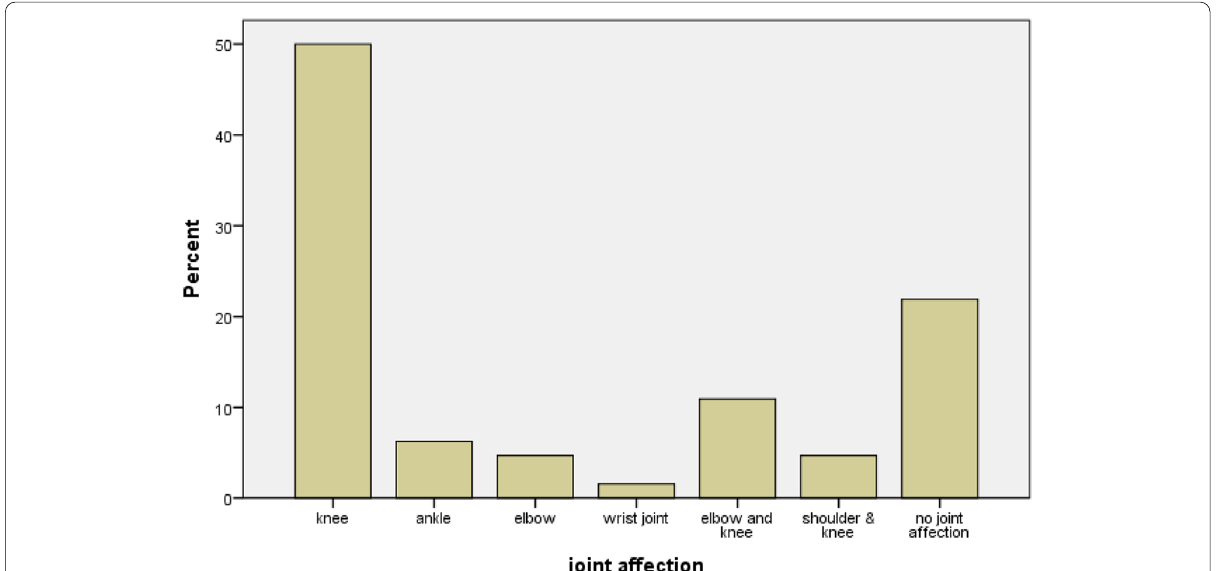
Fig. 2 The affected joints in the studied